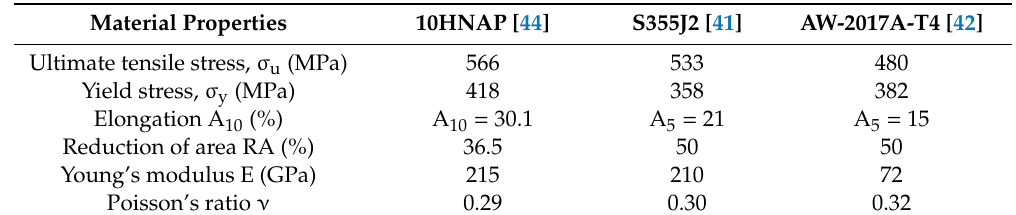
Table 2. Main mechanical properties of the tested alloys.